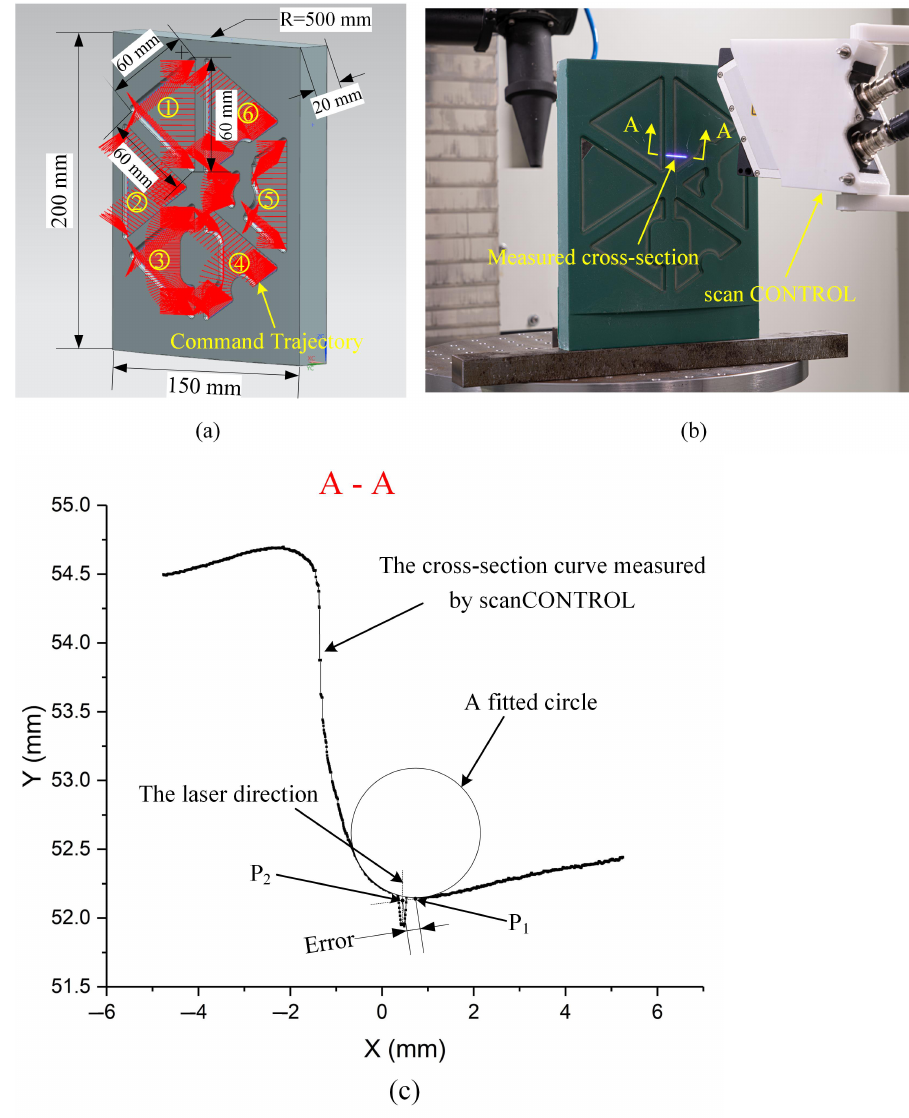
Figure 13. The dimension of the test part and the error measurement process. ( a ) The dimension of the test part and the command trajectory of laser engraving. ( b ) Overview of contour error measurement at a certain point. ( c ) Definition of error of the point